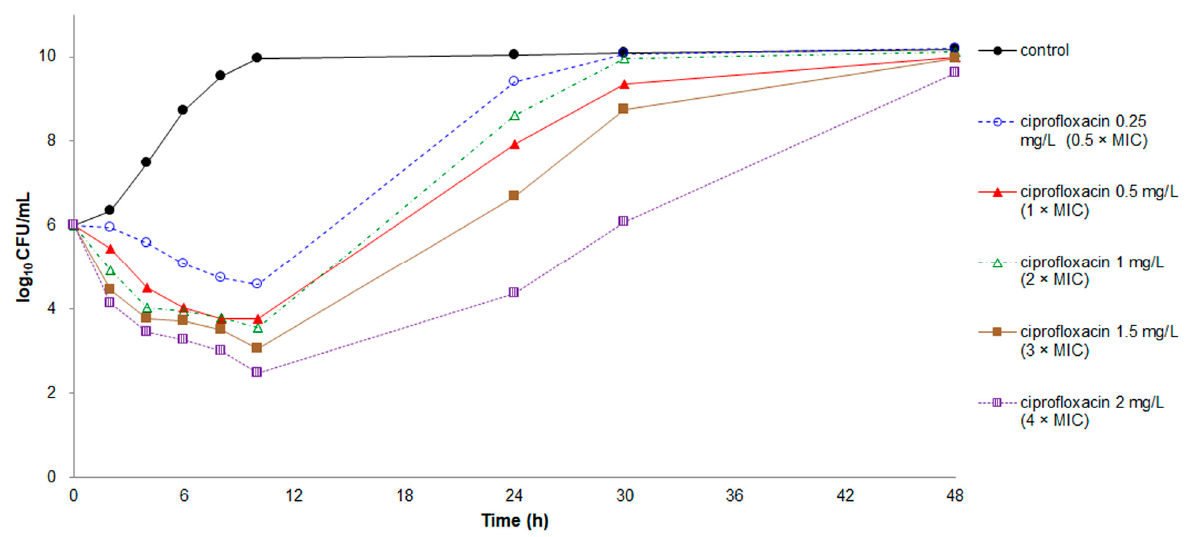
Figure 3. Time-kill assays for ciprofloxacin against E. anophelis strain ED853-49. Data points represent the mean of three experiments. MIC of ciprofloxacin = 0.5 mg/L.